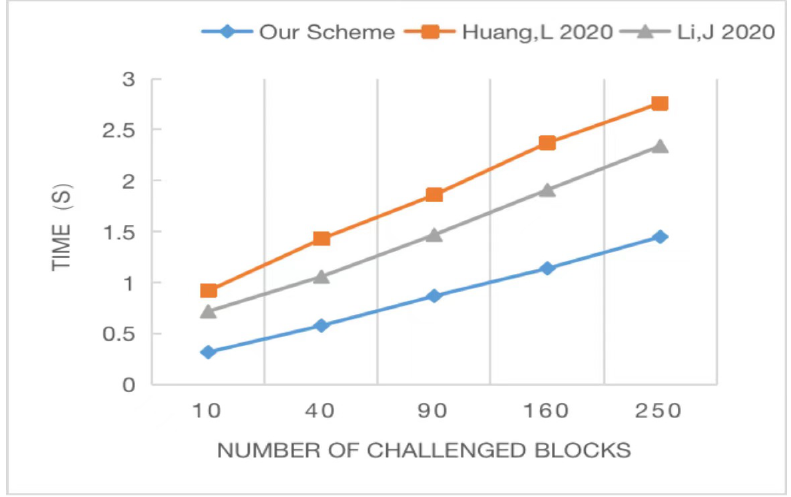
Figure 5. Computational cost for ProVer